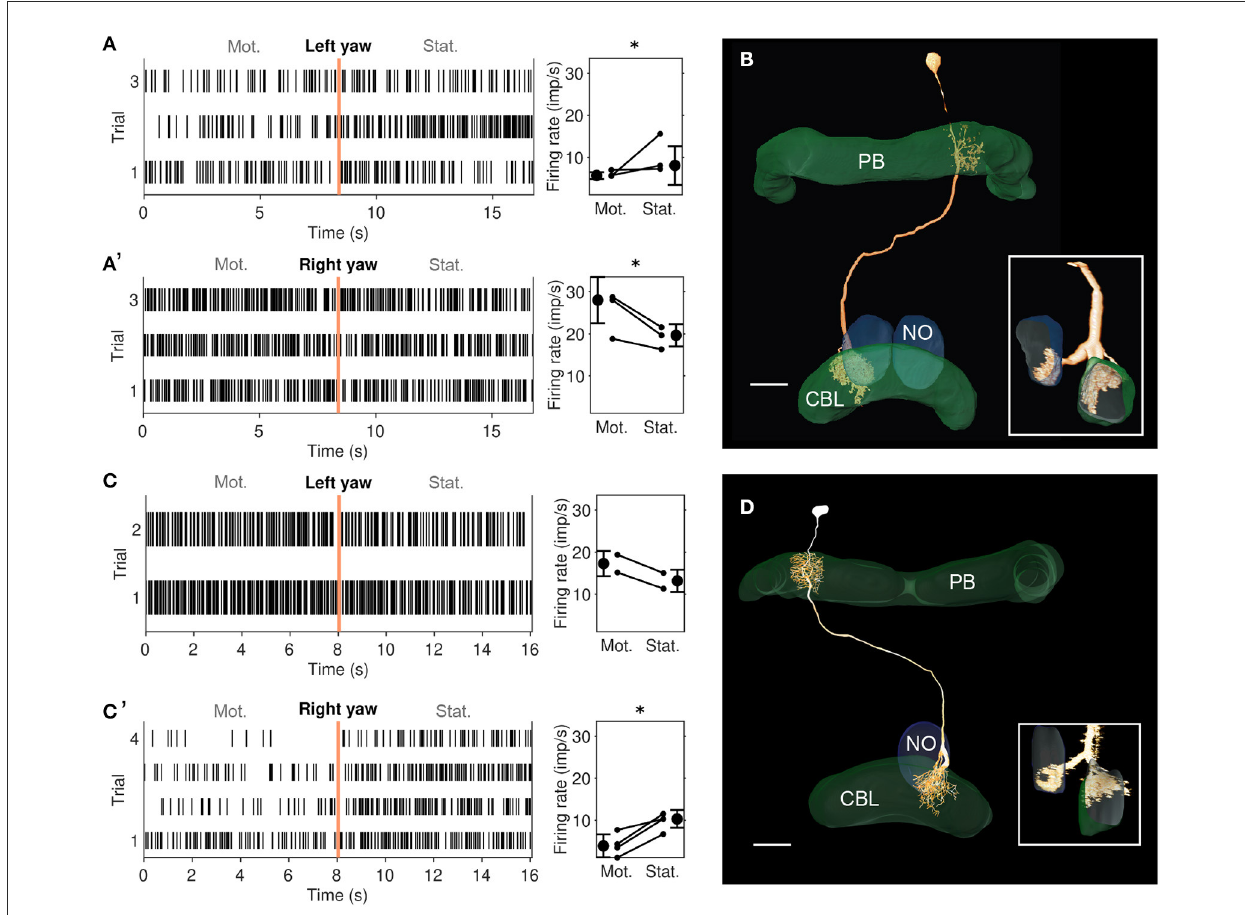
FIGURE4 Physiological responses to yaw rotation and projections of CL2 neurons. (A, A’) Physiological response (raster plots and mean firing rates) to left yaw rotation (A) and right yaw rotation (A’) of the CL2 neuron shown in B (unit 801 R in Supplementary Figures S1, S2). The neuron shows reduced firing rate during simulated left yaw and increased firing activity during simulated right yaw. Vertical lines in the raster plots indicate onset of the stationary phase. An asterisk indicates “strong evidence” in favor of the hypothesis that the firing rates differ between the motion and stationary phases (i.e., it indicates a Bayes factor ≥ 10 according to the conventions established by Kass and Raftery 1995). (B) Skeleton view of the CL2 neuron (view from posterior) recorded in (A, A’) . The neuron arborized in column R4 of the right hemisphere of the protocerebral bridge (PB), layers 1–3 of column L2 in the CBL, and in the lower unit of the left NO. Inset shows sagittal view of ramifications in the lower division of the central body (CBL), and the left nodulus (NO). Scale bar: 40 µ m. (C, C’) Raster plots and changes in firing rate during simulated yaw in the second CL2 neuron, shown in D (unit 800 L in Supplementary Figures S1, S2). The neuron increased its firing rate during simulated left yaw (C) and decreased its firing rate during simulated right yaw (C’) . Like in A, an asterisk indicates ’strong evidence’ for a firing rate difference between the motion and stationary phases. (D) Two-dimensional reconstruction of the neuron from confocal image stacks (view from posterior). It arborized in column L4 of the left hemisphere of the PB, column R2 in the CBL, and in the lower unit of the right NO. Inset shows sagittal voltex view illustrating ramifications in the CBL and NO. Scale bar: 40 µ